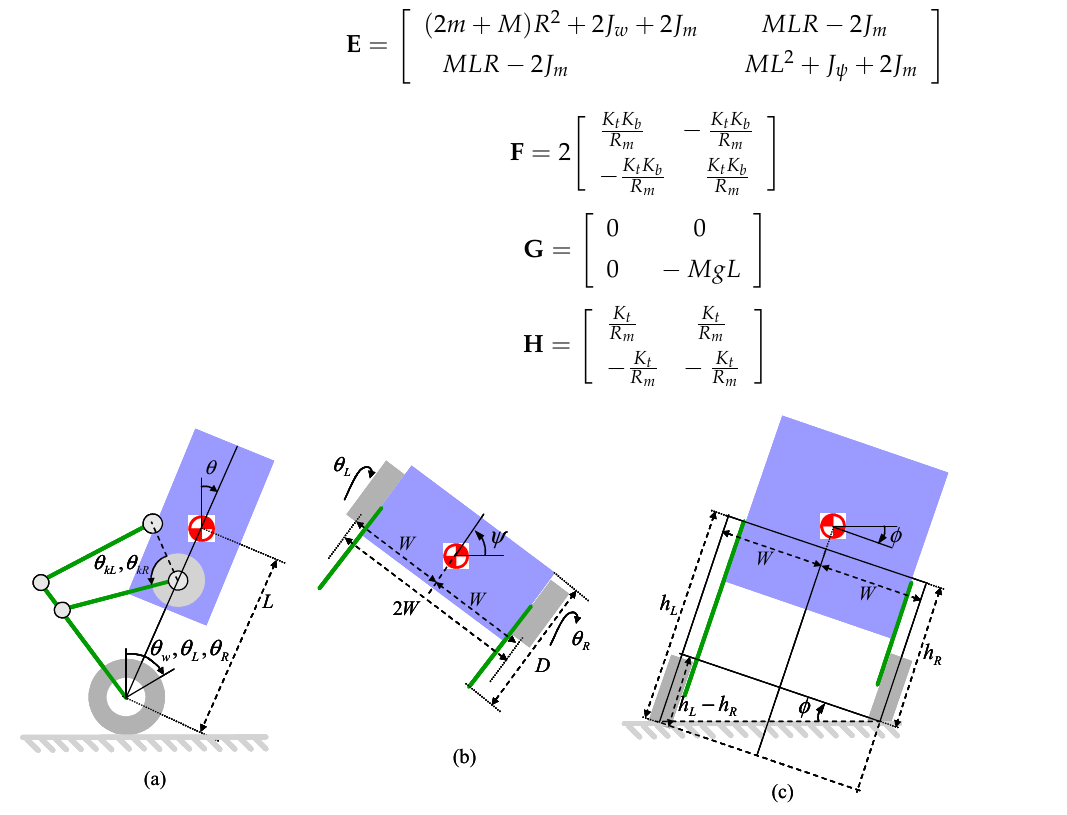
Figure 3. Generalized coordinates of the system. ( a ) Side view. ( b ) Top view. ( c ) Front view.